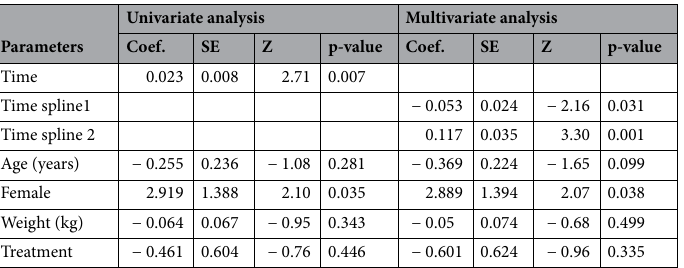
Table 1. Association between host factors and telomere dynamics during the controlled human malaria infection (n = 16,481 observations).